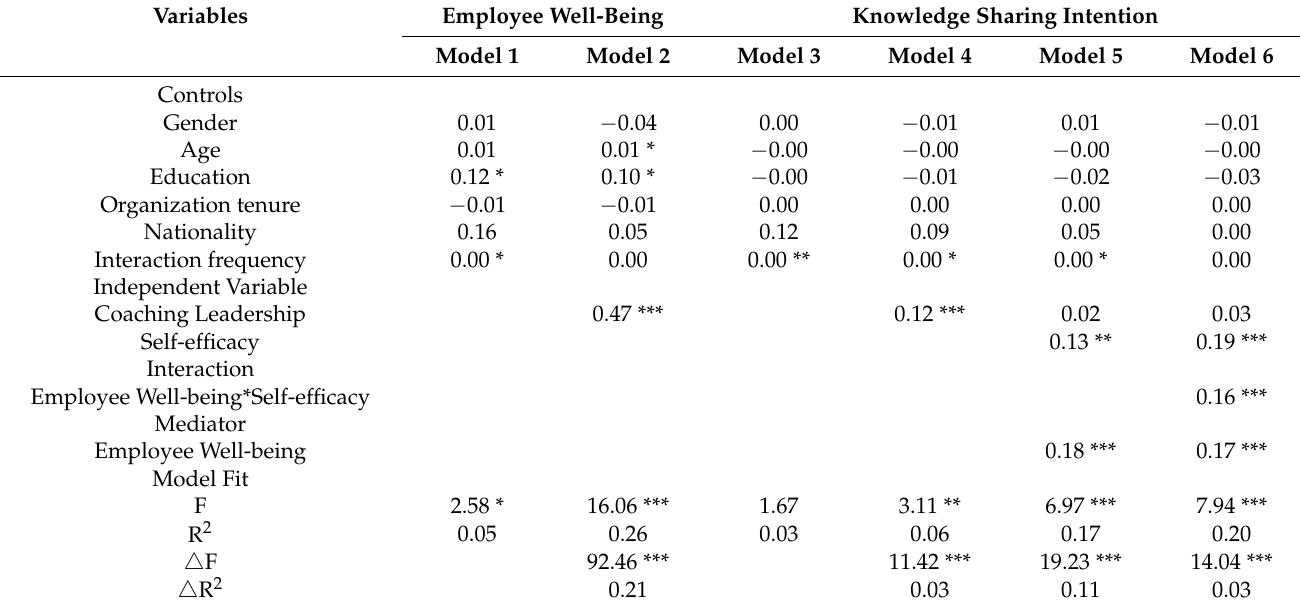
Table 3. Hierarchical multiple regression of employee well-being and knowledge sharing intention.